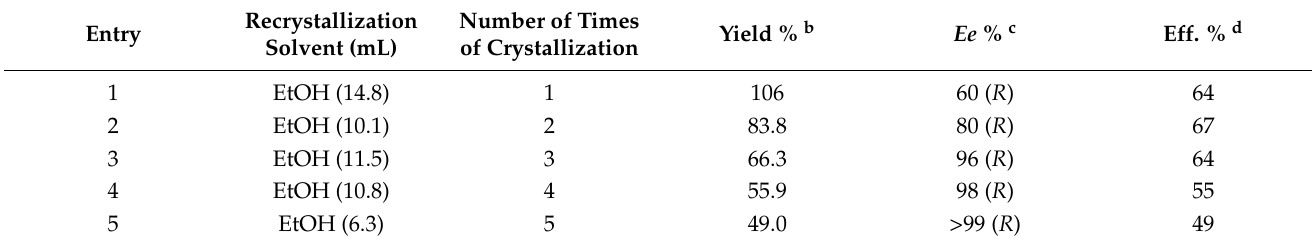
Table 7. Successive optical resolution of racemic 3-hydroxy-4-phenylbutanoic acid ( rac - 1 ) with cinchonidine a using EtOH.